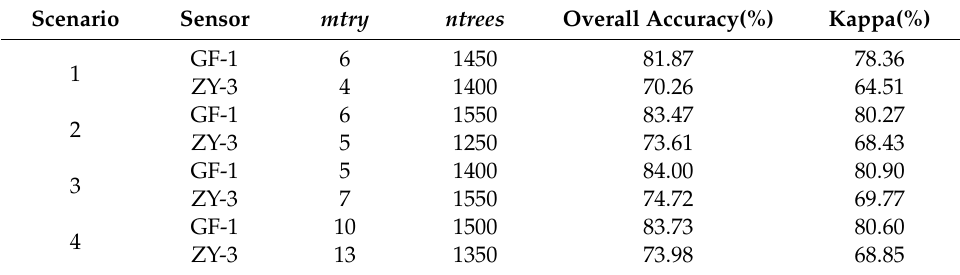
Figure 4. Overall accuracy of the Random Forest (RF) model for four scenarios of GF-1 and ZY-3 data with different combinations of mtry and ntrees . Table 6. The optimal parameters of object-based RF model for four classification scenarios of GF-1 and ZY-3 data.